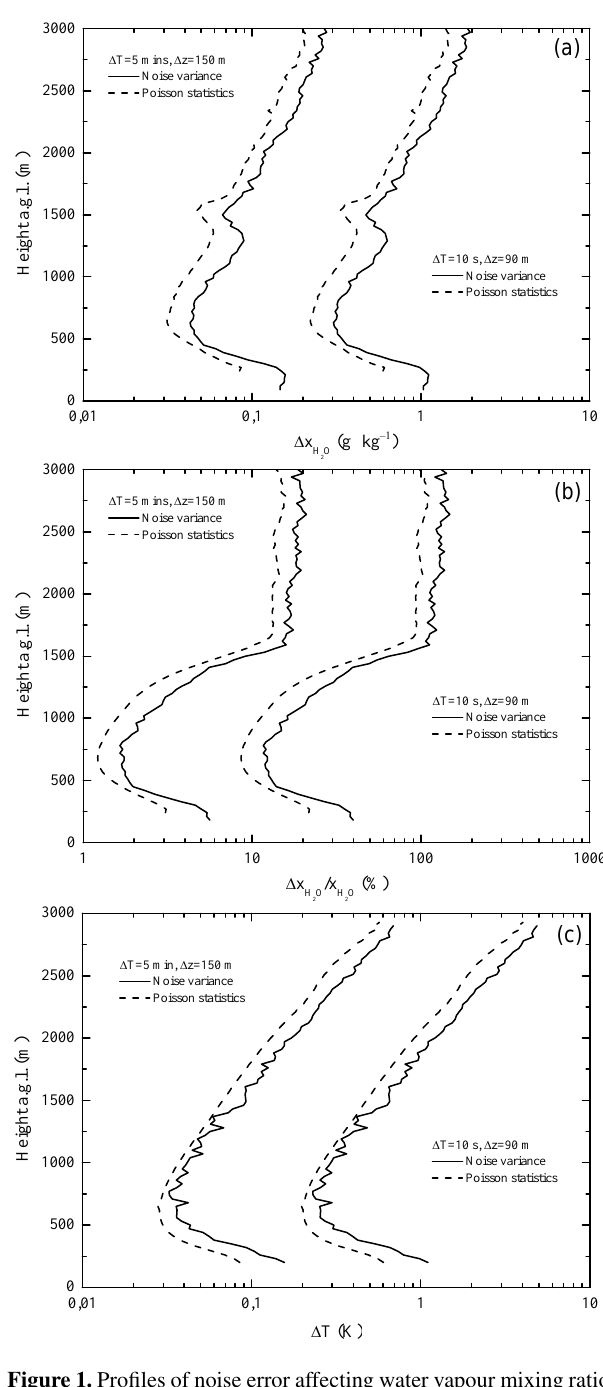
Figure 1. Profiles of noise error affecting water vapour mixing ratio ( a and b ) and temperature (c) measurements. The figure illustrates the estimates determined based on the application of the autoco- variance method, obtained by extrapolating the structure function to lag zero, and the error profiles obtained based on the application of Poisson statistics to signal photon